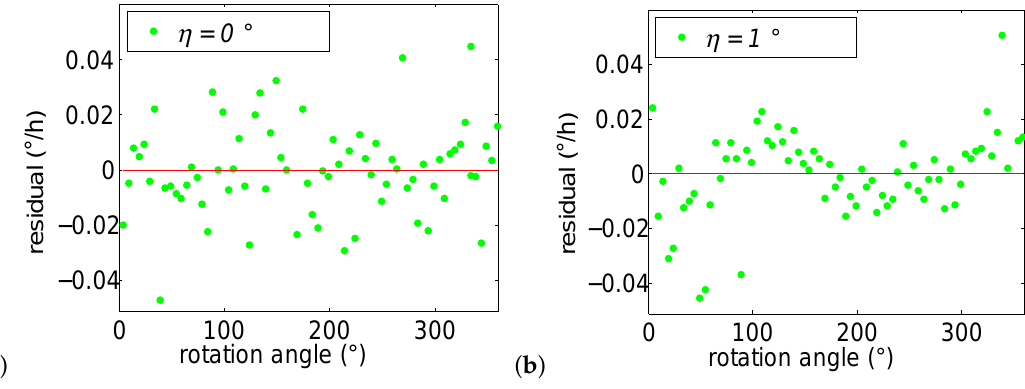
Figure 10. Gyro outputs residual. ( a ) aligned state. ( b ) misaligned